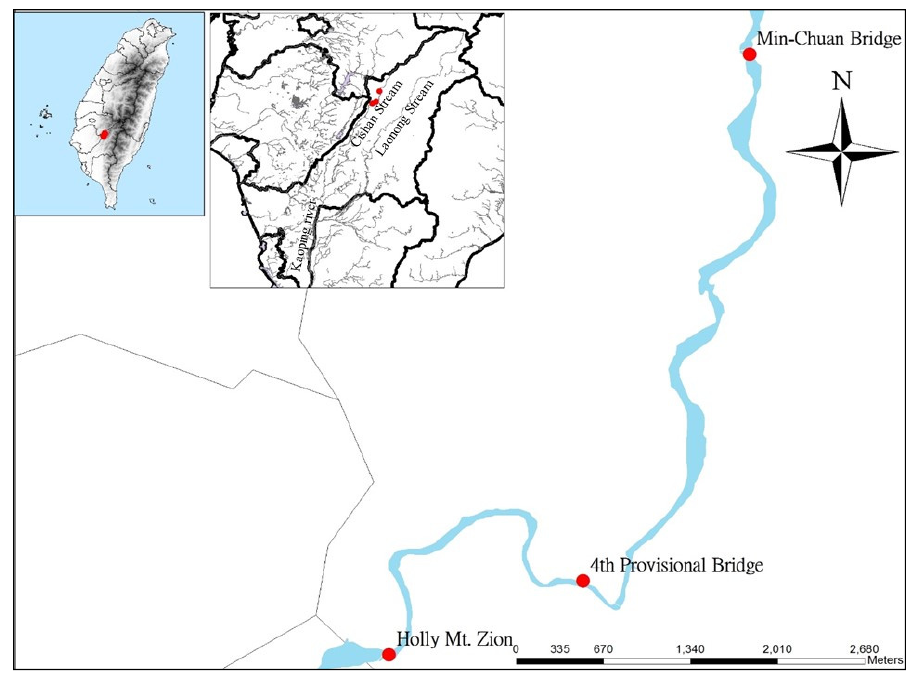
Figure 1. The surveyed stations in Cishan Stream.